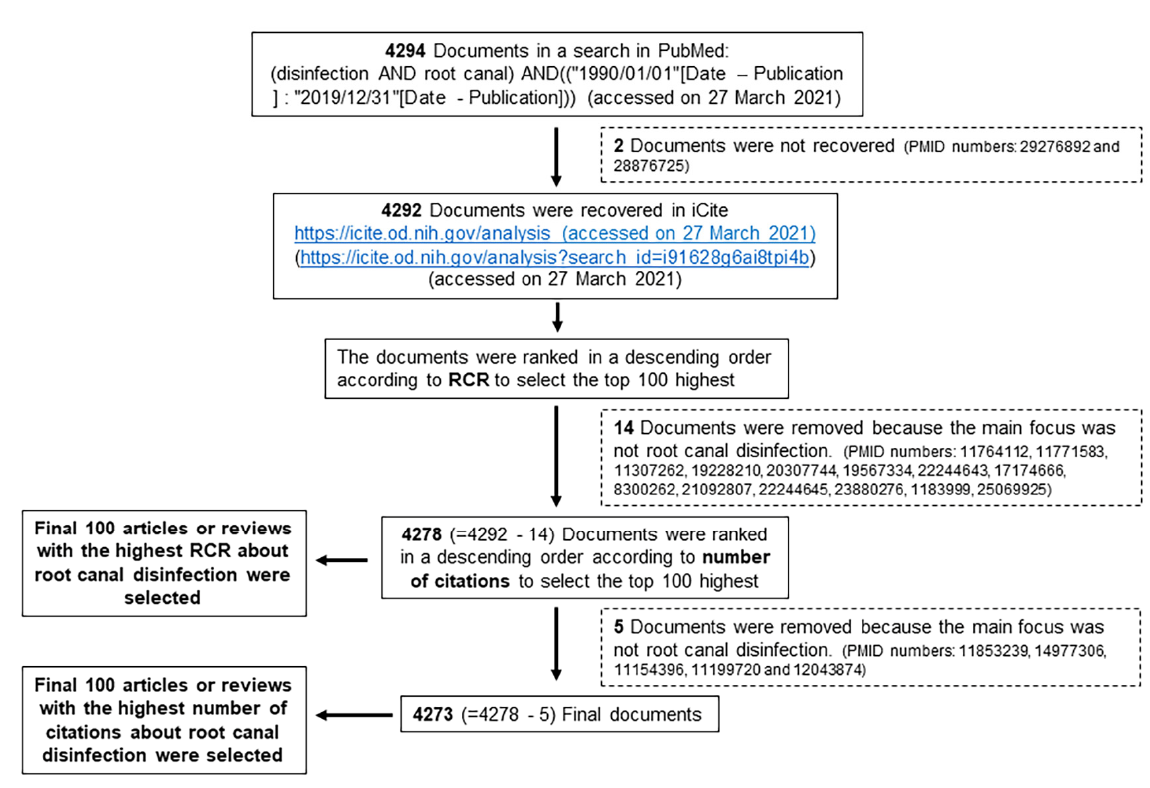
Figure 1. Flow diagram of the different steps taken to select the articles.